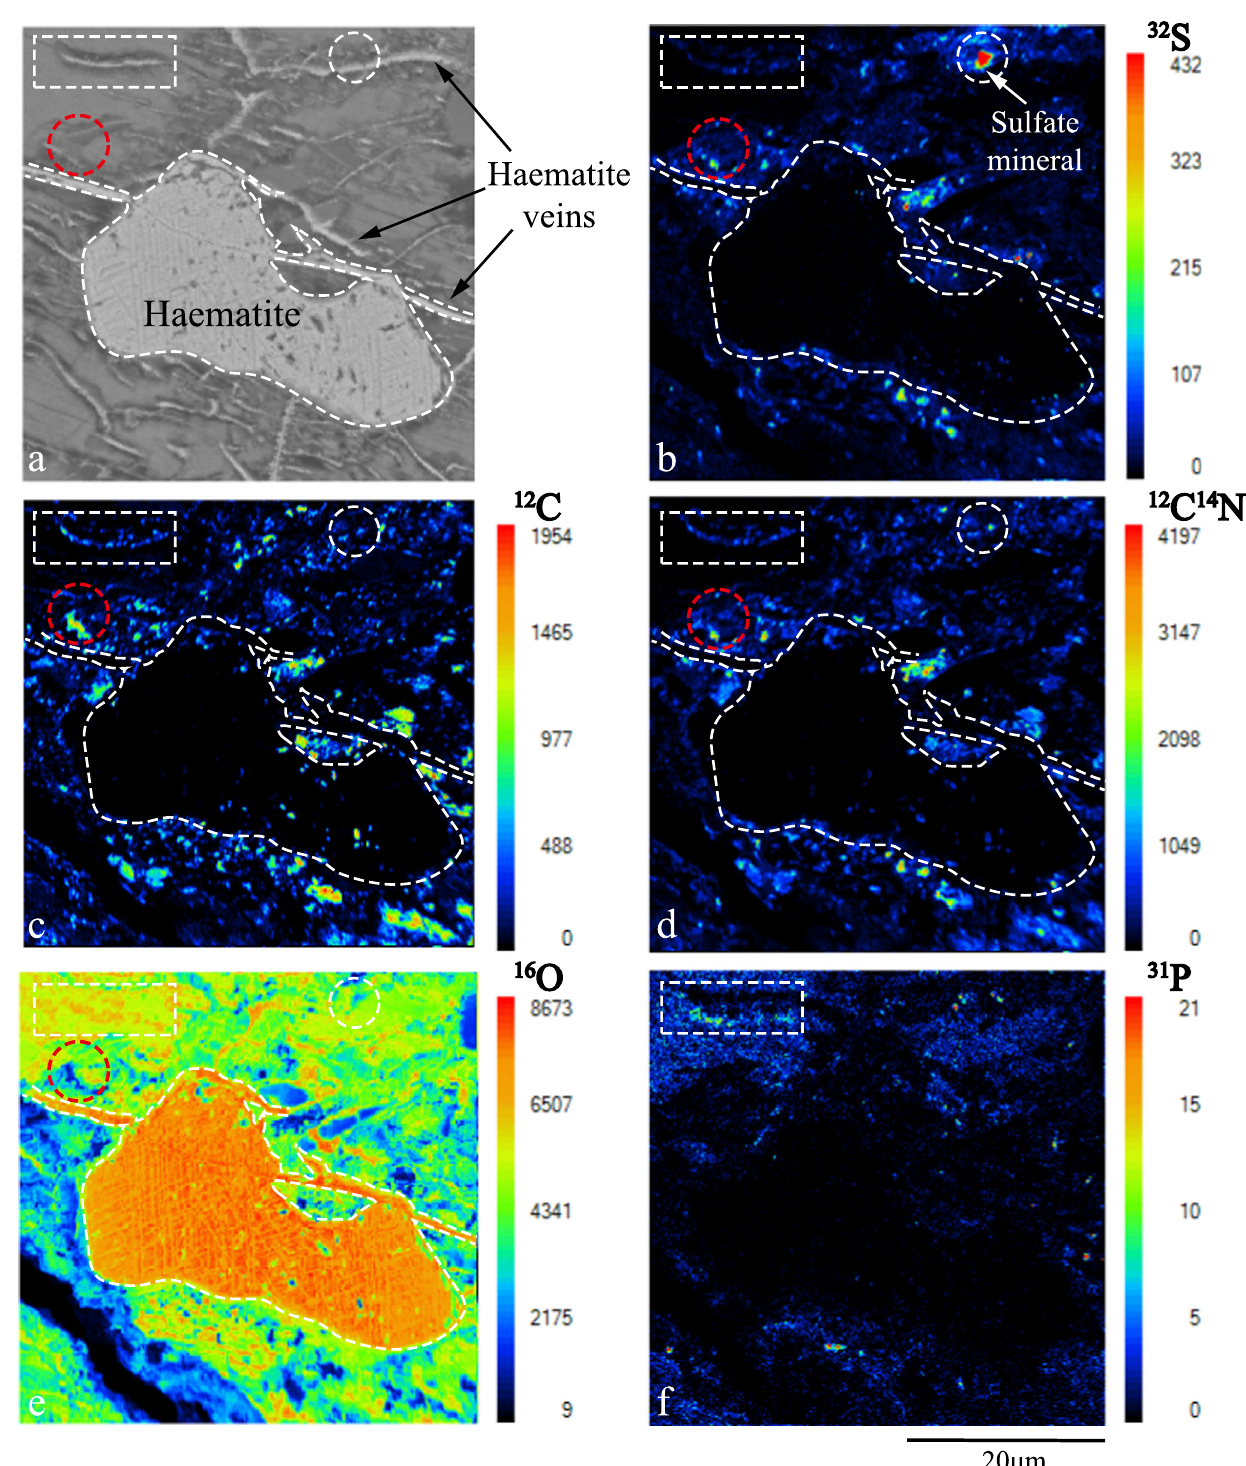
Fig. 2 Elemental analysis of typical altered minerals in tuffs by Nano SIMS surface analysis. a SEM image of altered hematite in TVG02-1; b – f 32 S, 12 C, 14 N, 16 O, and 31 P elements distribution map of the corresponding area of a , respectively. There are many disordered carbonaceous materials around the altered hematite, which are mainly composed of 12 C, 14 N, and 32 S elements, as exampled by the red dashed circle in the pictures. Granular sulfate mineral is also found as indicated by the white dashed circle next to the hematite vein. In addition, there is also enrichment of 12 C, 14 N, and 31 P elements along the arcuate hematite vein as shown in the white dashed box. The scale bar is 20 μ